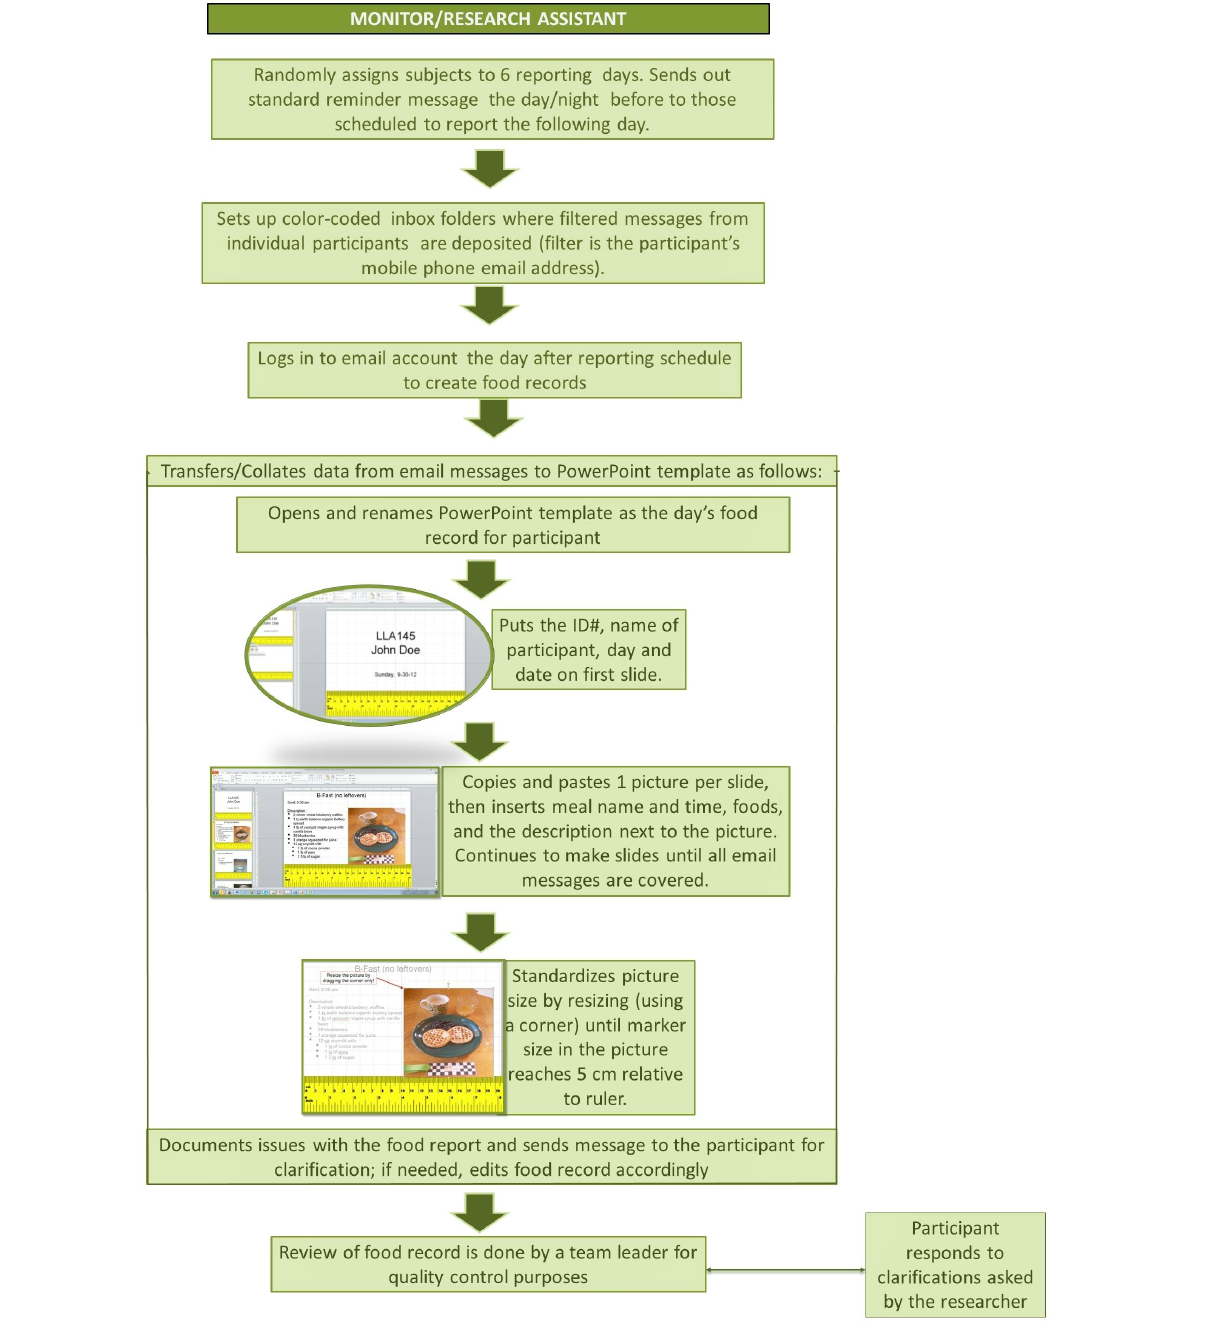
Figure 4. Diagram of the researcher procedure in collecting food records with digital images (FRDIs) using mobile phones by adolescents. The researcher provides real-time prompts and feedback during high-level intervention, but only asks for clarifications on reports from low-level intervention participants during next-day follow-up. ID: